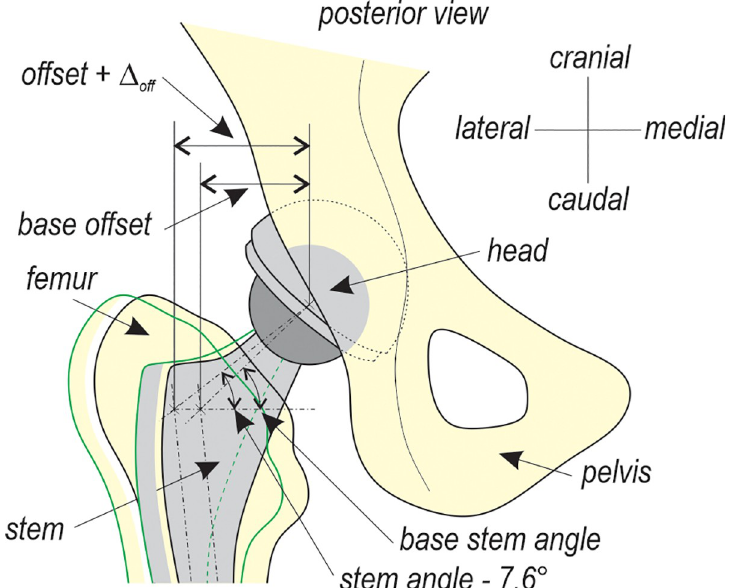
Fig 3. Offset definition. The green colour denotes a high offset.